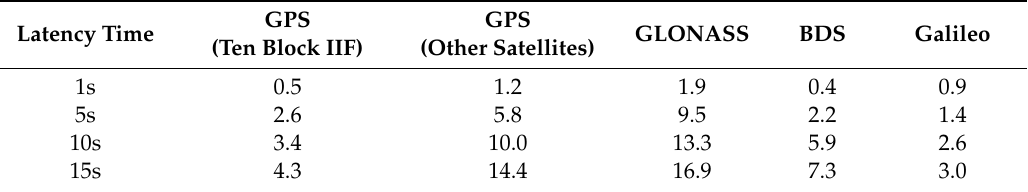
Table 6. Average RMS result (mm) for 1, 5, 10, and 15 s latency variation of broadcast ephemeris